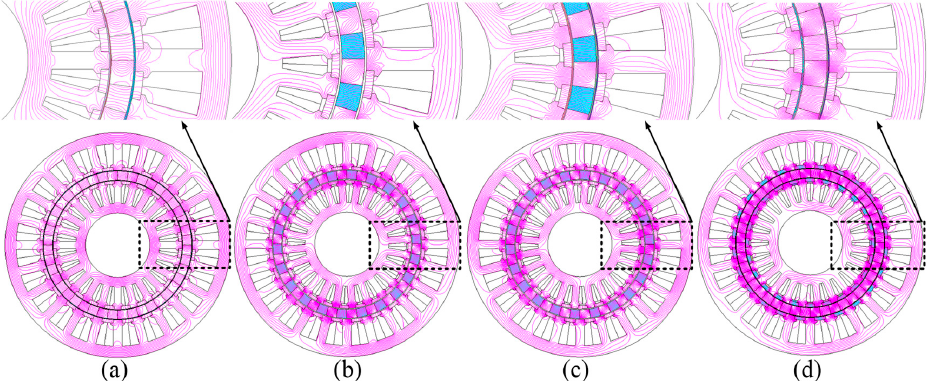
Figure 7. Magnetic field distributions. ( a ) β = 0; ( b ) β = 60; ( c ) β = 120; ( d ) β = 180.